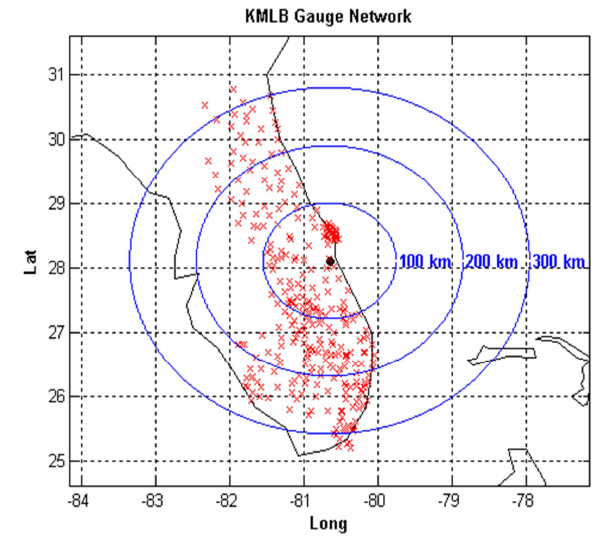
FIG. 2: KMLB gauge network. Fig. 2. KMLB gauge network.